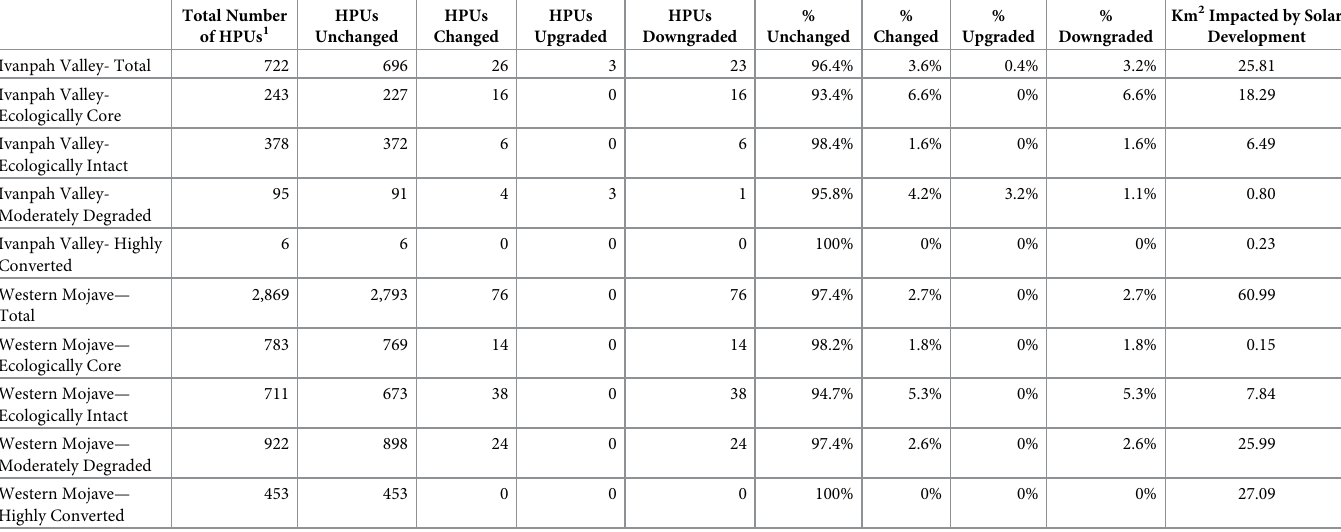
Table 5. Changes in conservation value